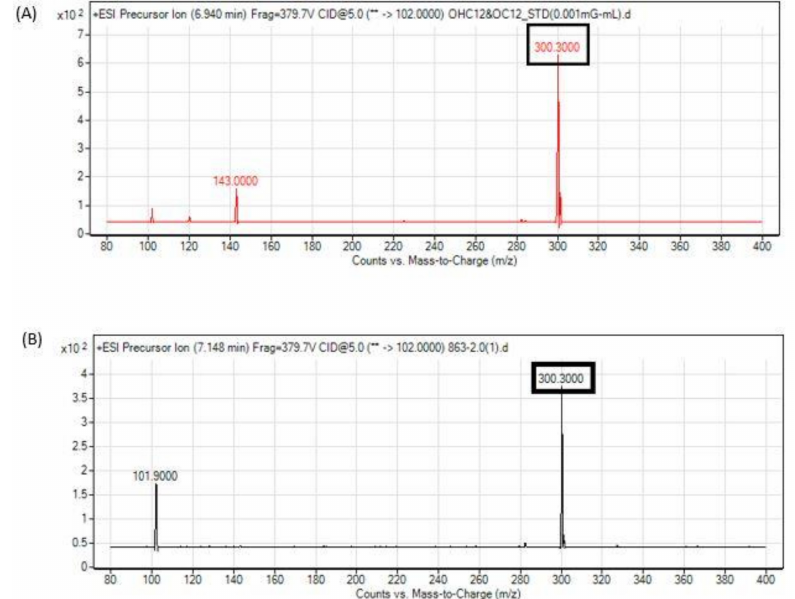
Figure 6. Mass spectrometry analysis shows the presence of a long chain AHL, hydroxy-C12 in the spent culture supernatant of strain 863. ( A ) Mass spectra of synthetic hydroxyl-C12 and ( B ) hydroxyl-C12 from strain 863. A peak at m / z 300.3 was detected which indicated the presence of hydroxyl-C12.